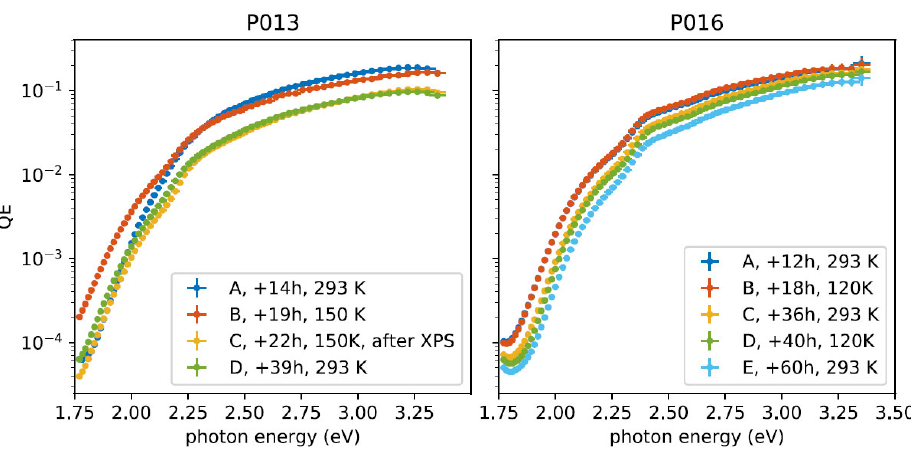
Figure 10. Spectral response of K 2 CsSb cathodes (sample #P013 and#P016) during the cryogenic cooling experiments performed in the HZB photocathode preparation chamber [47].